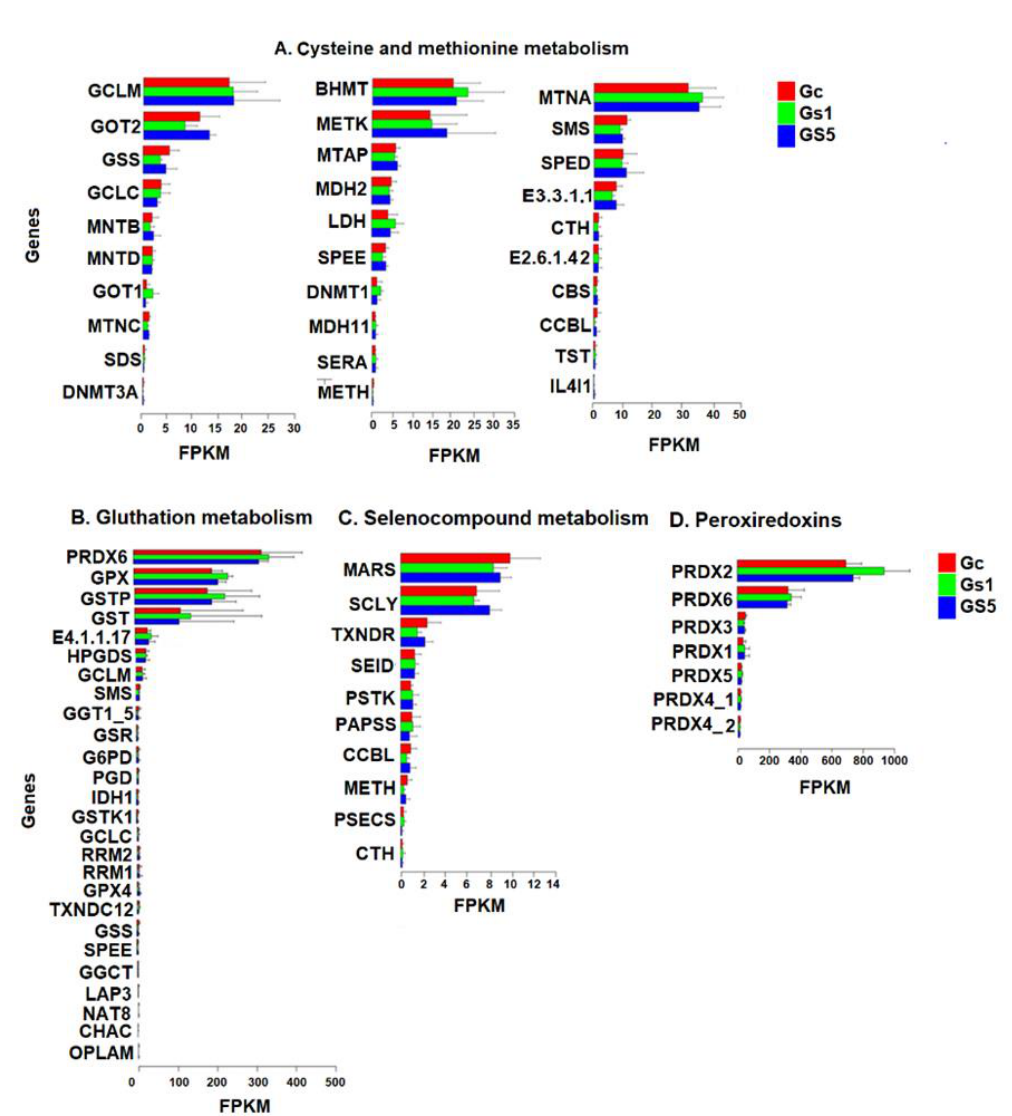
Figure 9. Relative gene expression (FPKM) in loggerhead turtle RBCs in different metabolic pathways. ( A ) cysteine- methionine metabolism, ( B ) metabolism of glutathione, ( C ) metabolism of selenocompounds, and ( D ) metabolism of perox- iredoxins.